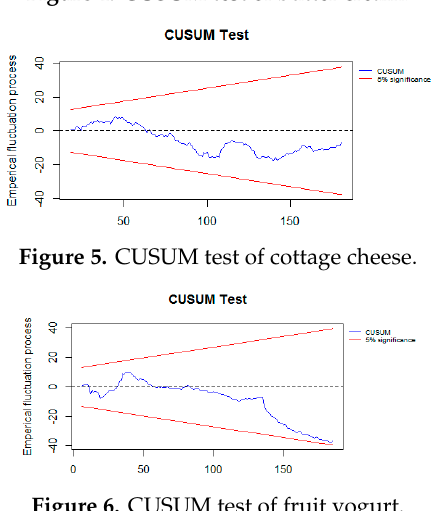
Figure 6. CUSUM test of fruit yogurt.